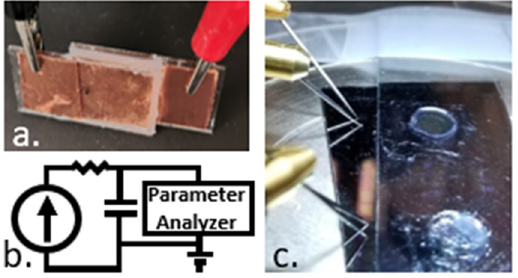
Figure 2. ( a ) Bio-gel EDLC device under test ( b ) Testing setup with constant current source, parameter analyzer and device under test. ( c ) EGOFET equivalent device and OEGFET equivalent device under test.